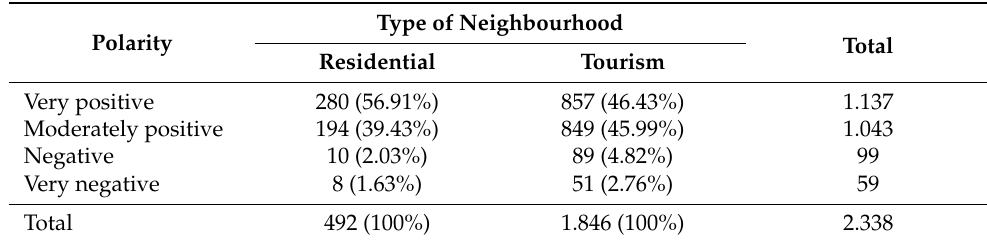
Table 5. Results of sentiment analysis by type of neighbourhood.